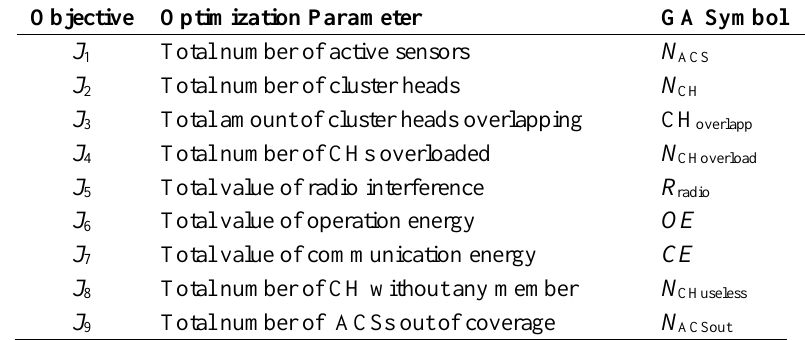
Table 1. Correspondence between optimization parameters and objectives.